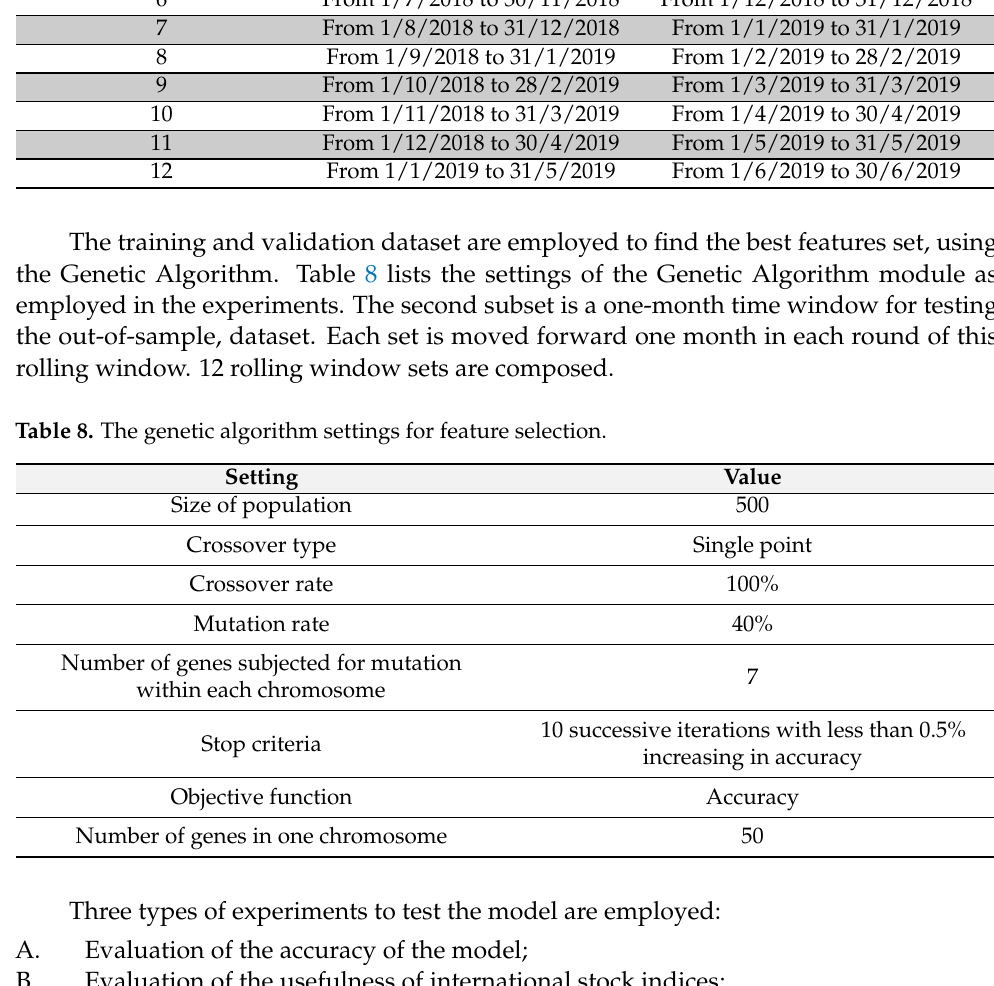
Table 7. Dataset splitting into a rolling window from 2 January 2018 to 30 June 2019. Rolling Windows ID